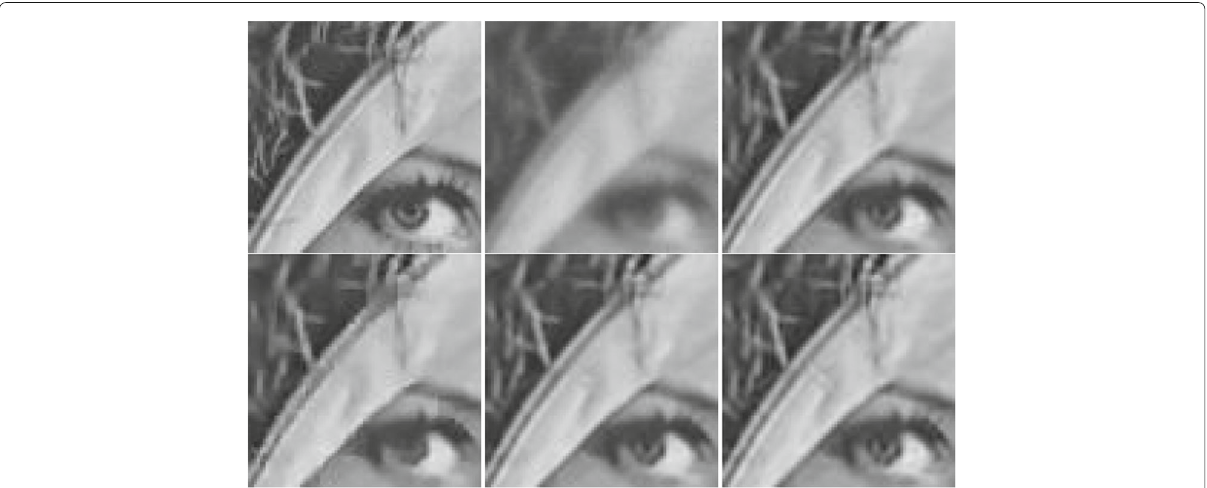
Fig. 2 Deblurring of Lena image, scenario 2. From left to right and from top to bottom are presented zoomed fragments of the following images: original , blurred , and noisy , reconstructed by BM3DDEB, L0-Abs, IDD-BM3D, and our method. In our method, the two input parameters used, (σ , s ) , are ( 7.5,25 ) for this scenario, ( 7.5,85 ) for scenario 1, ( 7.5,550 ) for scenario 3, ( 7.5,10 ) for scenario 4, ( 7.5,50 ) for scenario 5, and ( 7.5,5 ) for scenario 6